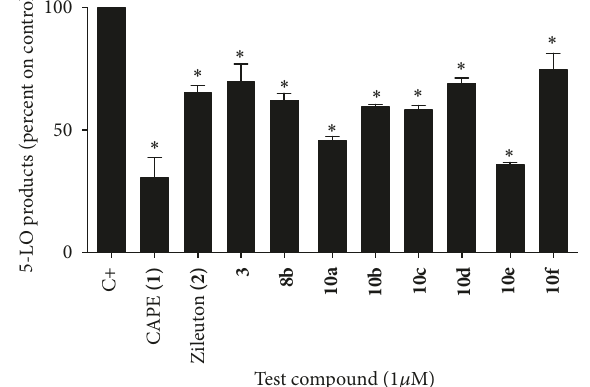
Figure 4: Inhibition of 5-LO products synthesis by 10a– f in whole HEK293 cells. Values are the means ± SEM of three independent experiments, each performed in quadruplicate; ∗ different from control (diluent) as determined by one-way ANOVA with Dunnett’s multiple comparison test ( 𝑝 < 0.05 ).